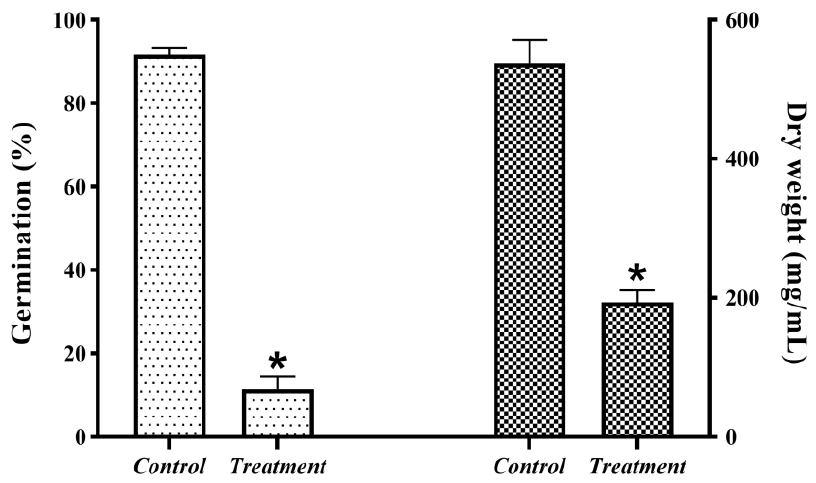
Figure 3. JK-25 exerts an antagonistic effect on mycelial growth and spore germination of B. sorokiniana. Data are presented as the average ± the standard deviation and * indicates a significant difference between treatment groups within a parameter (Duncan’s multiple range test at p ≤ 0.05).